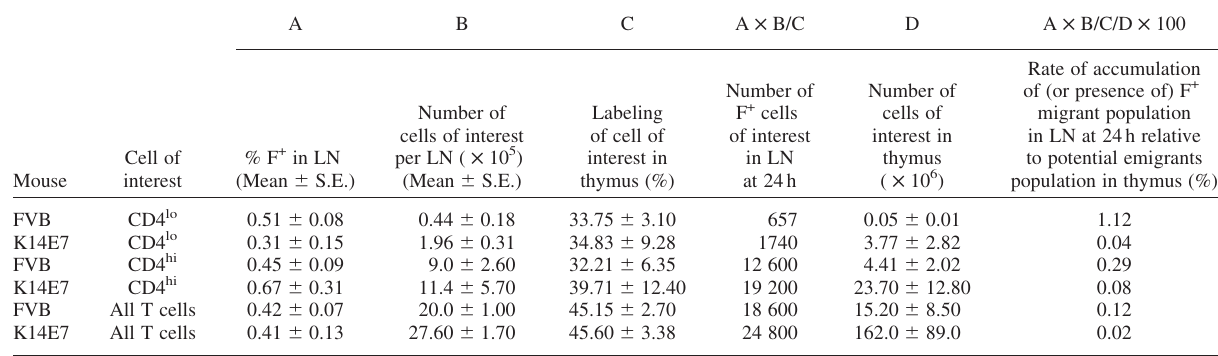
TABLE III Migration of FITC-labeled thymocytes to the inguinal LN in 3 month old